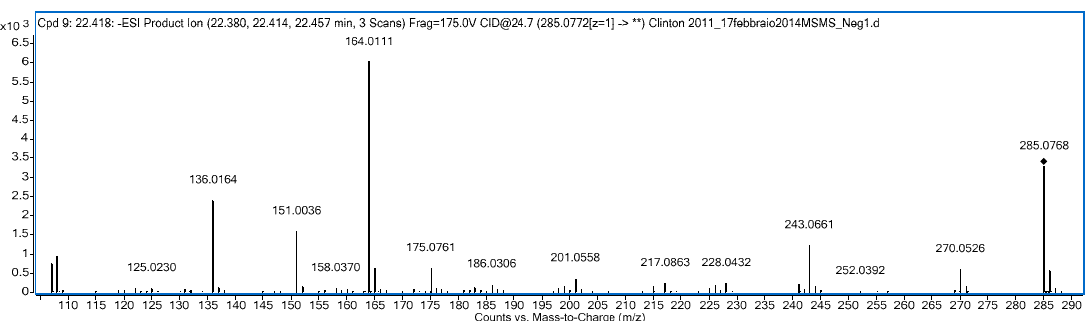
Figure 1. Ultra-high performance liquid chromatography quadrupole-time of flight multiple mass spectrometry (UHPLC-Q/TOF) spectrum of putative methyl-naringenin isomer identified in the grape.